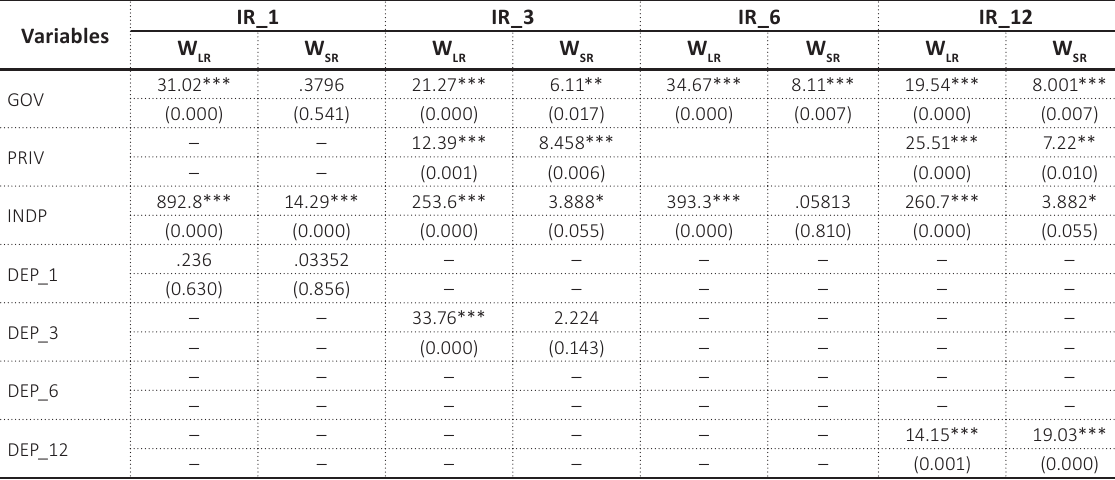
Table 4. Wald test of long-run and short-run asymmetry